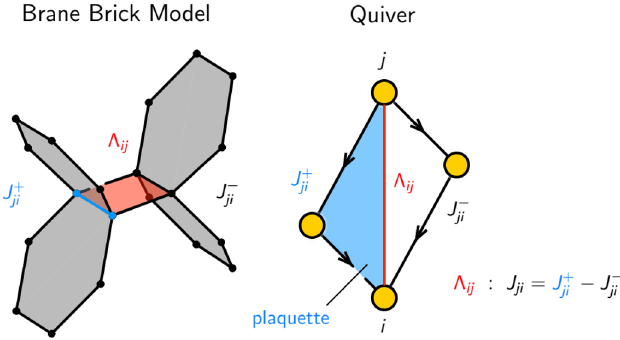
Figure 8 . 2 d brick faces in the brane brick model can be systematically oriented along their boundary edges such that oriented even-sided faces correspond to chiral fields and unoriented 4-sided faces correspond to Fermi fields.